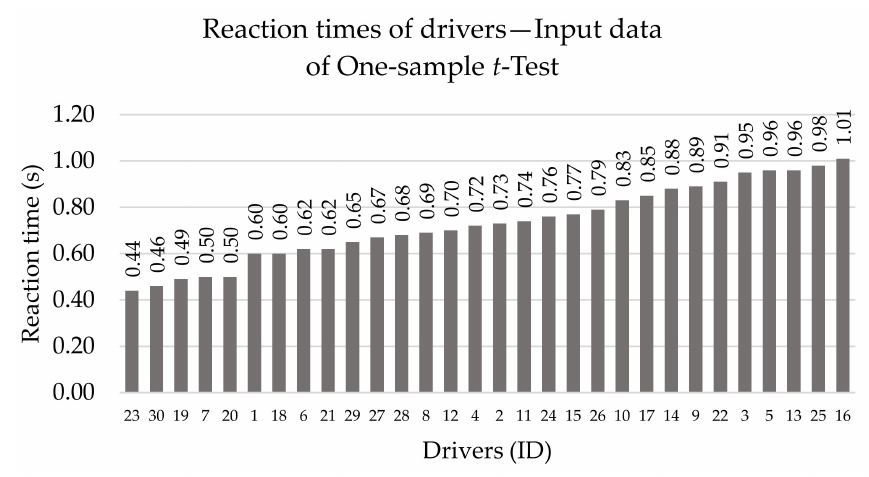
Figure 3. Input data of one-sample t -test. Source: Processed by